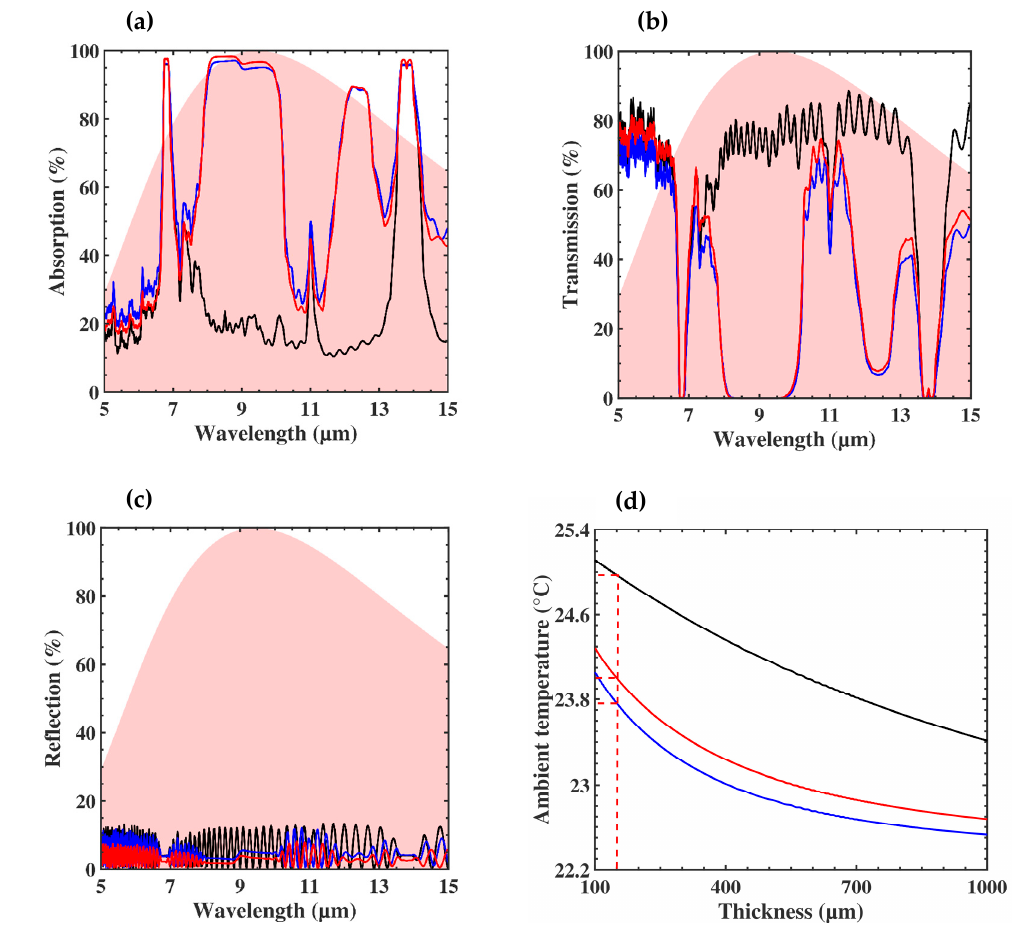
Figure 5. ( a ) Absorption, ( b ) transmission, and ( c ) reflection spectra in the mid-infrared (MIR) for membrane thickness of 150 µ m. The black curves correspond to the PE membrane free of submicron particles, the blue and red ones to the PE and nanoPE membranes containing 5% SiO 2 submicron particles, respectively. The shaded area corresponds to the human body radiation at 34 ◦ C. ( d ) Evolution of the required ambient temperature to achieve thermal comfort T S = 34 ◦ C as a function of the thickness of the three membranes.